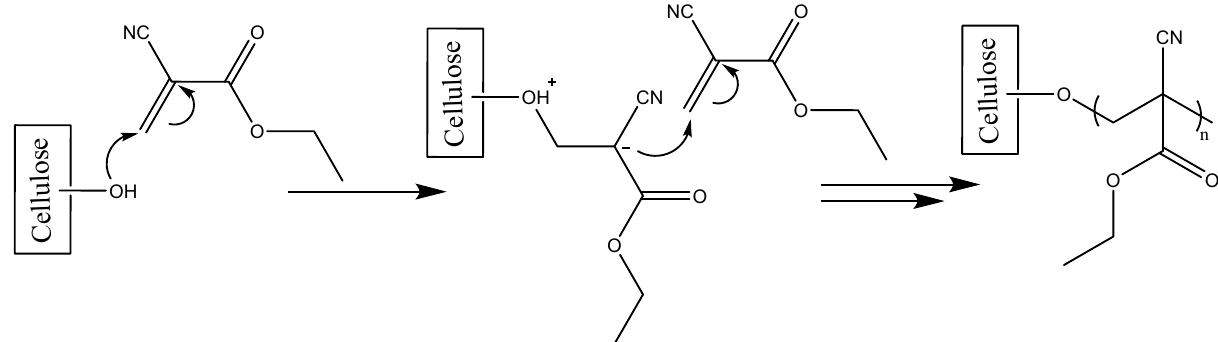
Figure 3. Plausible mechanism of addition of hydrophobic agent into the surface of cellulose